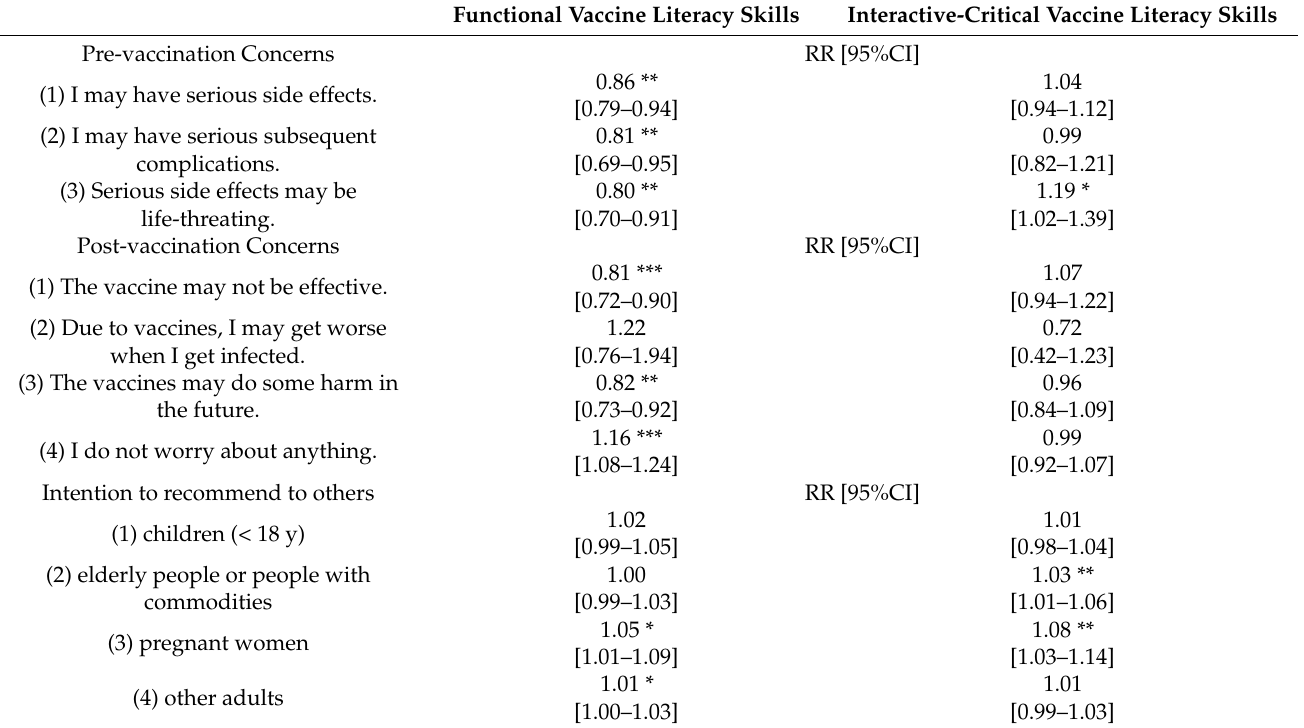
Table 3. Continuous analysis for each vaccine literacy (functional and interactive-critical) level